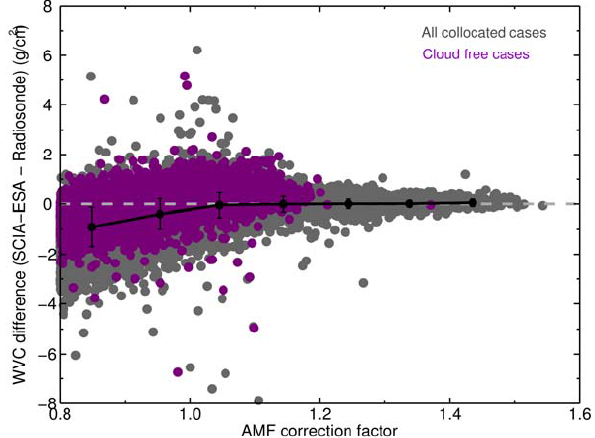
Fig. 8. SCIAMACHY-ESA and radiosonde WVC differences for Figure 8. SCIAMACHY-ESA and radiosonde WVC differences for all individual collocated all individual collocated cases shown as a function of the AMF CF. Measurements where the SCIAMACHY-ESA cloud fractions are cases shown as a function of the AMF CF. Measurements where the SCIAMACHY-ESA equal to zero are indicated in purple. Grey points indicate all other cloud fraction are equal to zero are indicated in purple, gray points indicate all other cloud cloud fraction cases. Black indicates the mean WVC difference of binned categories (AMF CF values at intervals of 0.1), and vertical fraction cases, black indicate the mean WVC difference of binned categories (AMF CF values black bars indicate the standard deviation from this mean. at intervals of 0.1) and vertical black bars indicate the standard deviation from this mean.